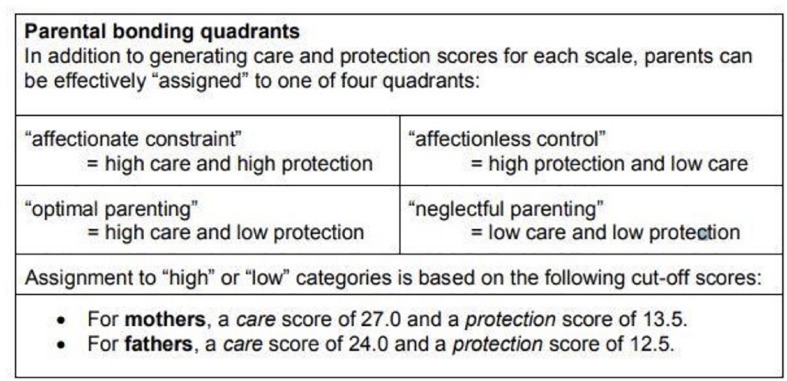
Assigining parenting styles using the PBI (Parker, 1979 #192).